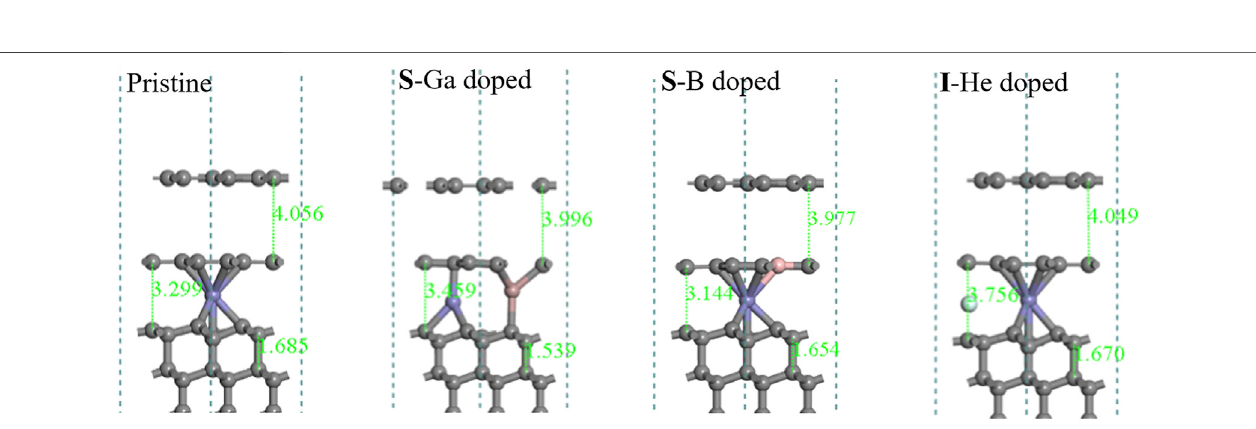
FIGURE 9 | Optimized structures of pristine and doped diamond (111) surfaces with Fe atoms diffused through the second bilayer.